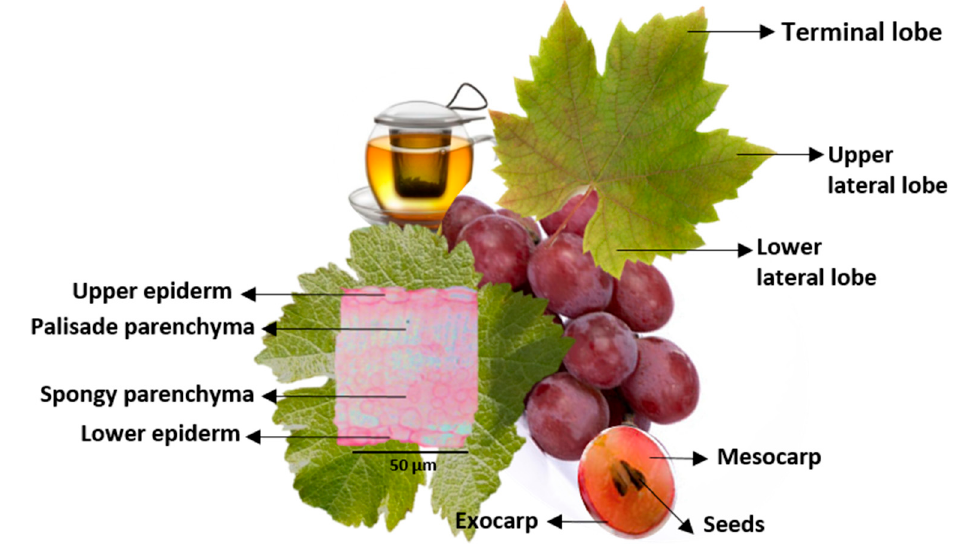
Figure 4. Schematic structures of a vine leaf and a grape berry.